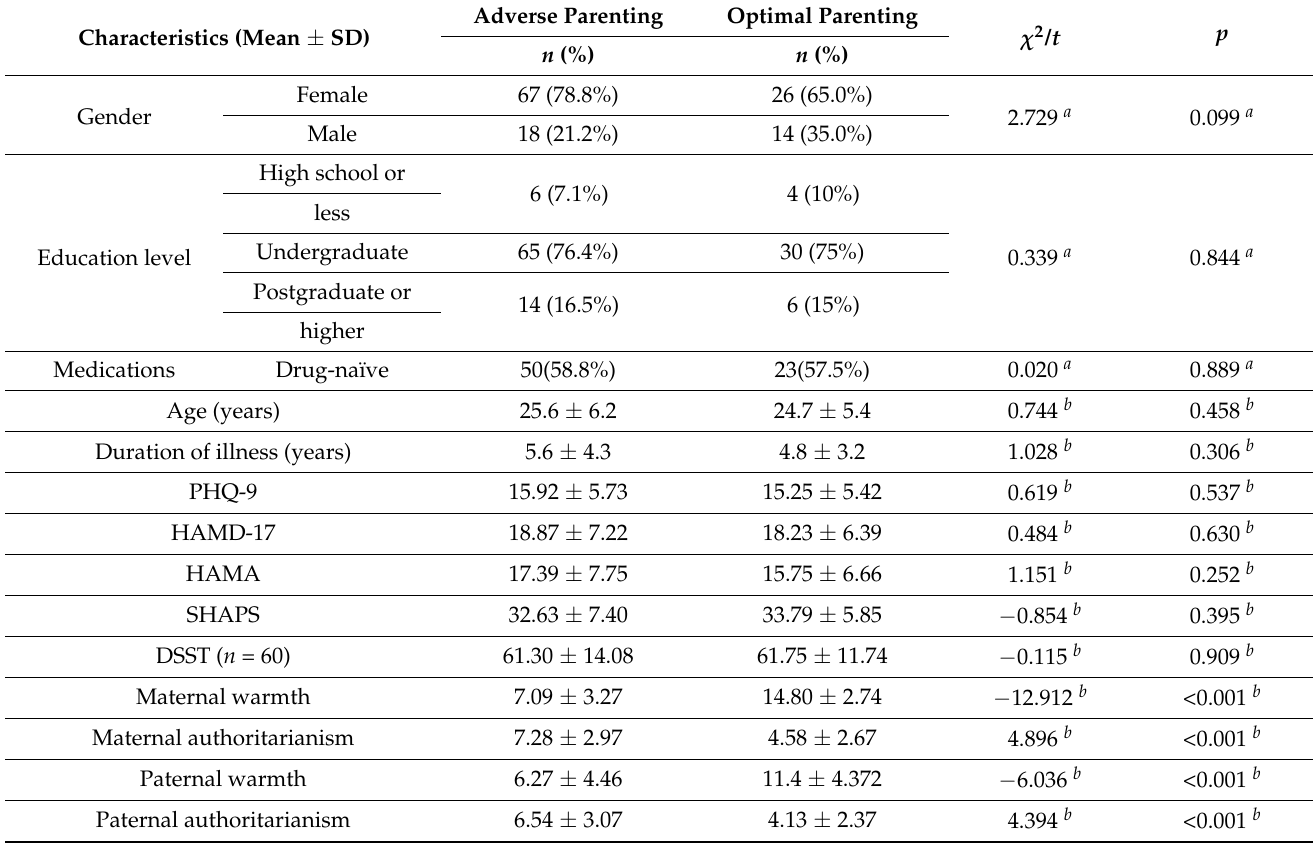
Table 1. Demographics and clinical characteristics.